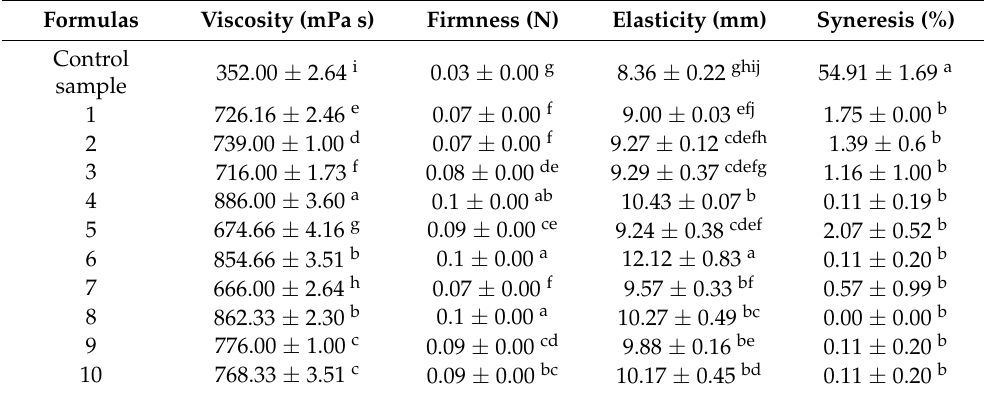
Table 4. Values of viscosity, firmness, elasticity, and syneresis of the formulas.